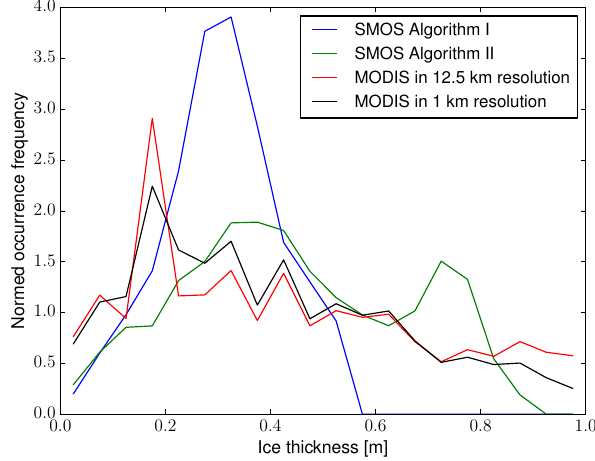
Figure 20. Histogram of SMOS (Algorithm I and II) and MODIS (in 12.5km and 1km grid resolution) ice thicknesses from all pixels of the selected 30 days between 2009 and